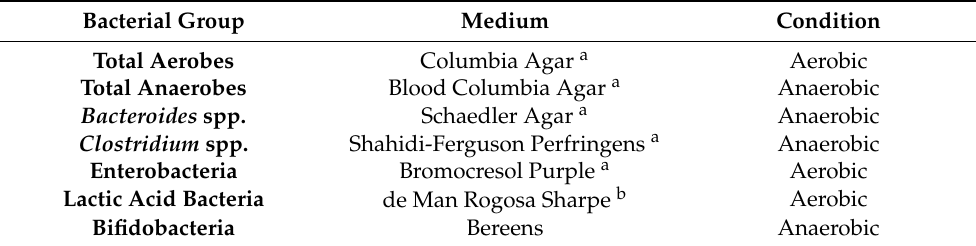
Table 2. Media and conditions used to determine counts of anaerobic and aerobic